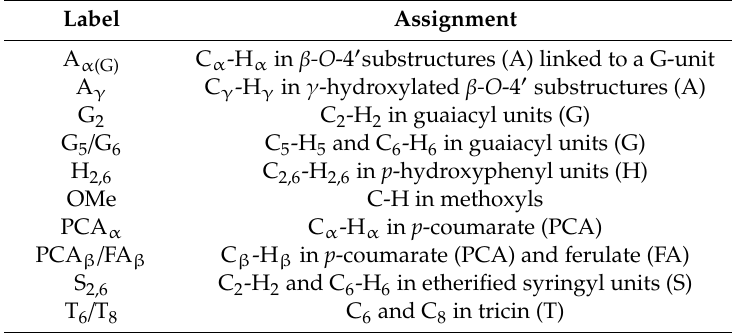
Table 5. Assignments to the labels in Figures 4–6, see Figure 7 for the structures identified.